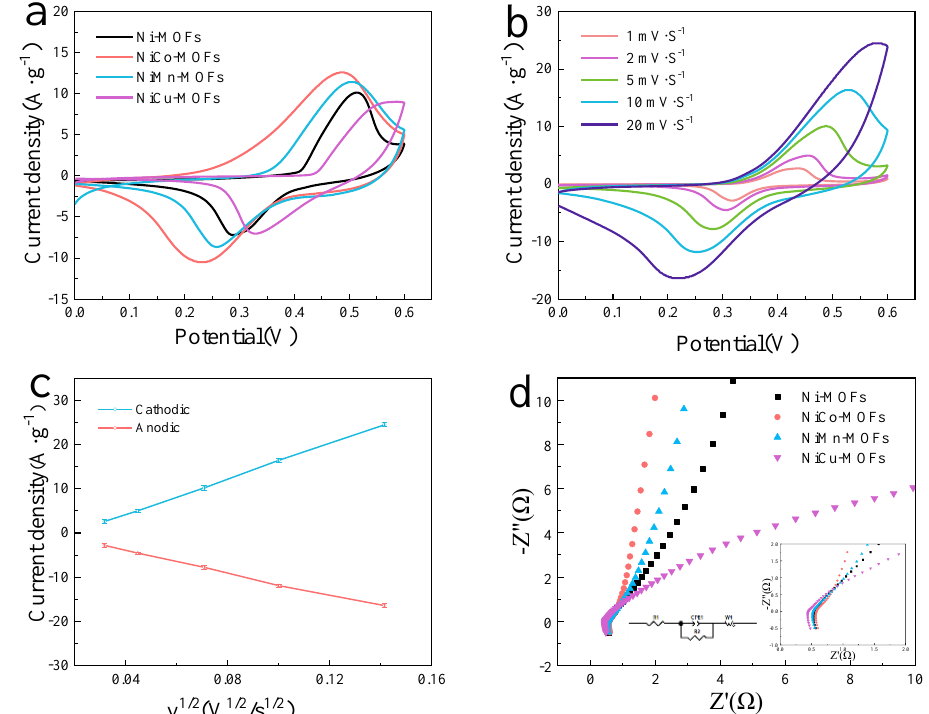
Figure 4. ( a ) CV curves of four samples at 5 mV · s − 1 ; ( b ) CV curves of NiCo − MOFs at 1–20 mV · s − 1 ; ( c ) plots of the peak currents and the scan rates of NiCo − MOFs; ( d ) Nyquist plots of four samples; the equivalent circuit is shown in the embedded diagram.